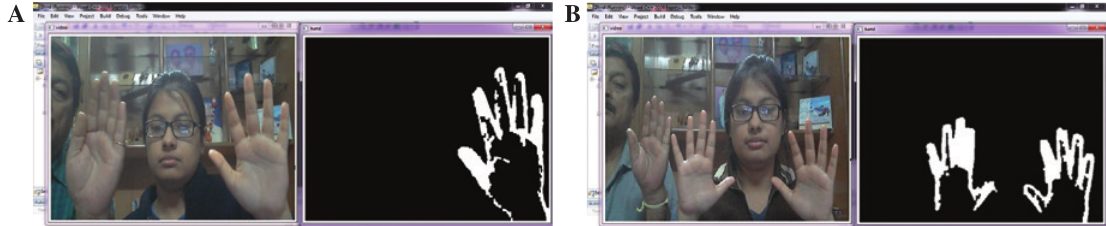
Figure 9: Segmented Output Using the Proposed Method for a Complex Background Having Multiple Gesturers.